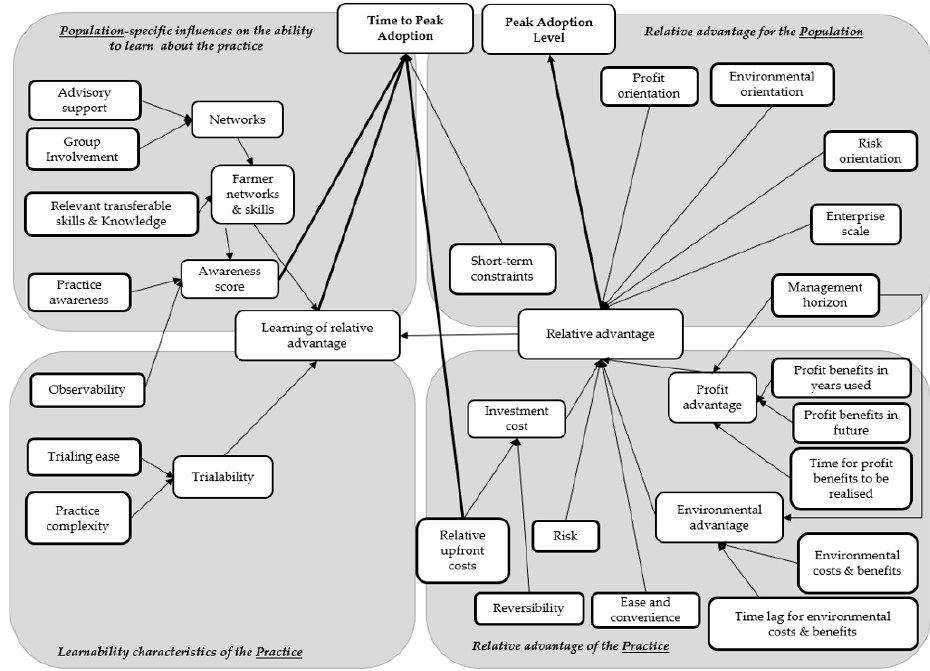
Figure 3. The ADOPT conceptual model. Based on Kuehne et al. [14]. (Permission